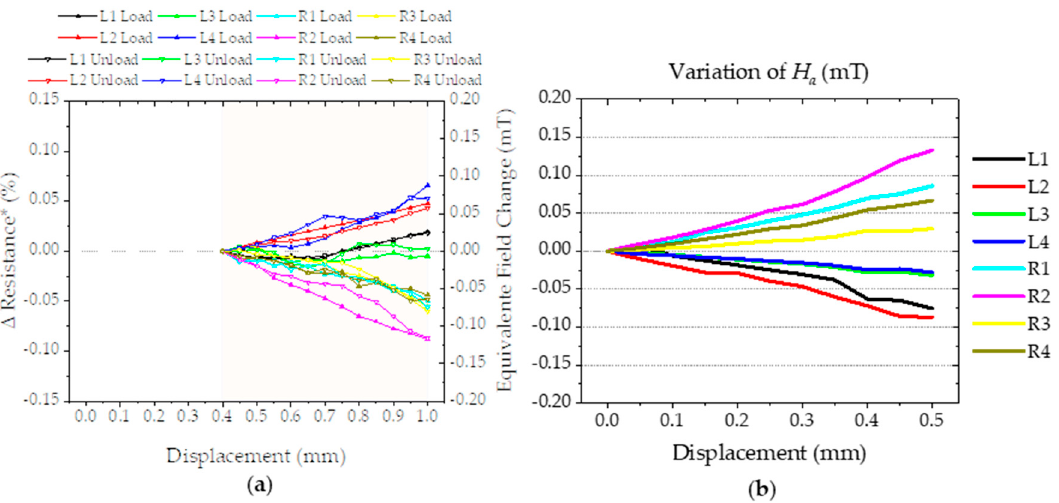
Figure 18. ( a ) Experimental results: sensor output as a function of displacement for phase III. ( b ) Simulated results considering change in angle.